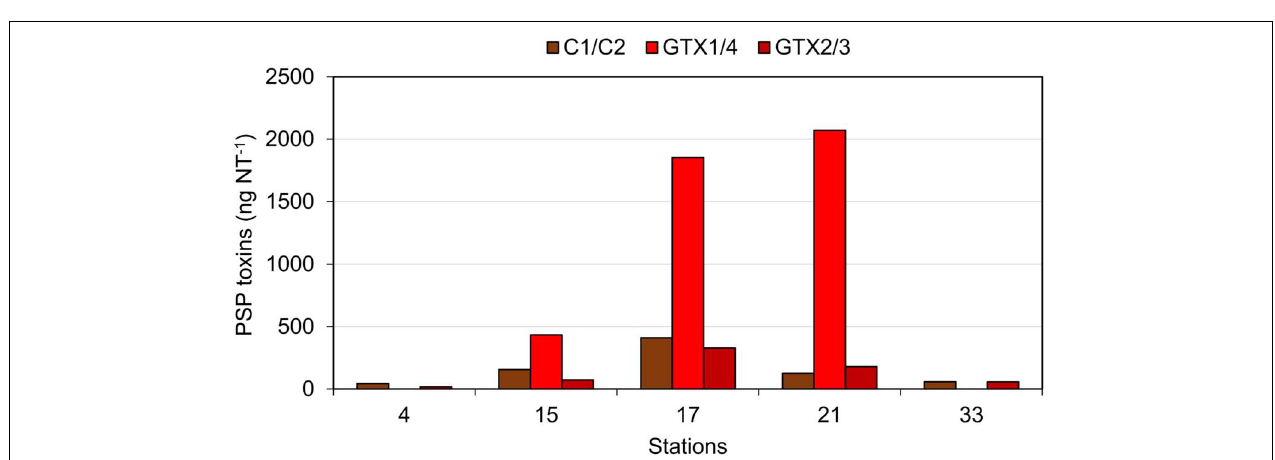
FIGURE 10 | The PSP toxins detected in net hauls of plankton. Note that the water columns sampled at different stations were not normalized and quantitative comparisons among stations are not